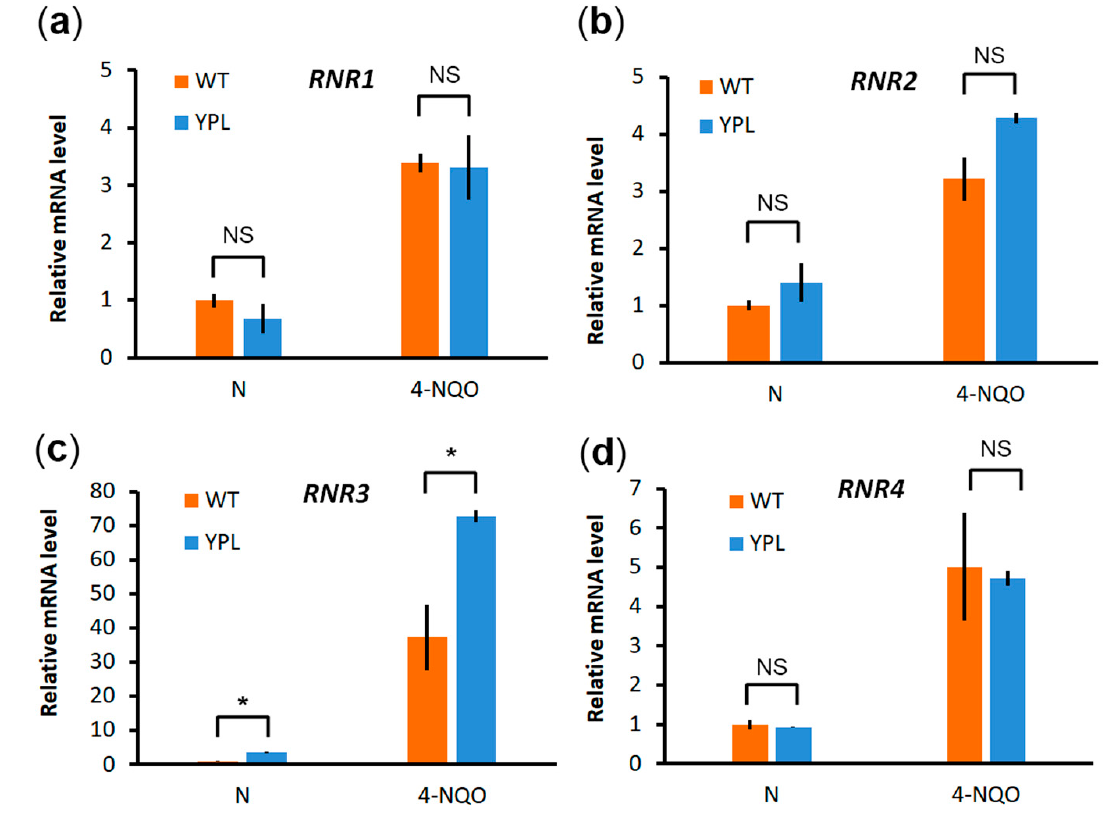
Figure 3. The relative mRNA levels of RNR1 ( a ), RNR2 ( b ), and RNR4 ( d ) genes do not differ significantly in the WT strain from the YPL strain with impaired proteasome activity, whereas for RNR3 ( c ) they are significantly higher in the YPL strain than in the WT strain. The mRNA levels were measured by RT-PCR under normal conditions or after treatment with 4-NQO at a final concentration of 2 µg/mL for 45 min. ACT1 was used as a reference. The relative mRNA level in the WT strain under normal conditions was set to 1 for each gene. The plot shows the mean values ( n = 3) ± SDs. Statistical significance: NS, not significant; * p < 0.05, according to Student’s t -test.